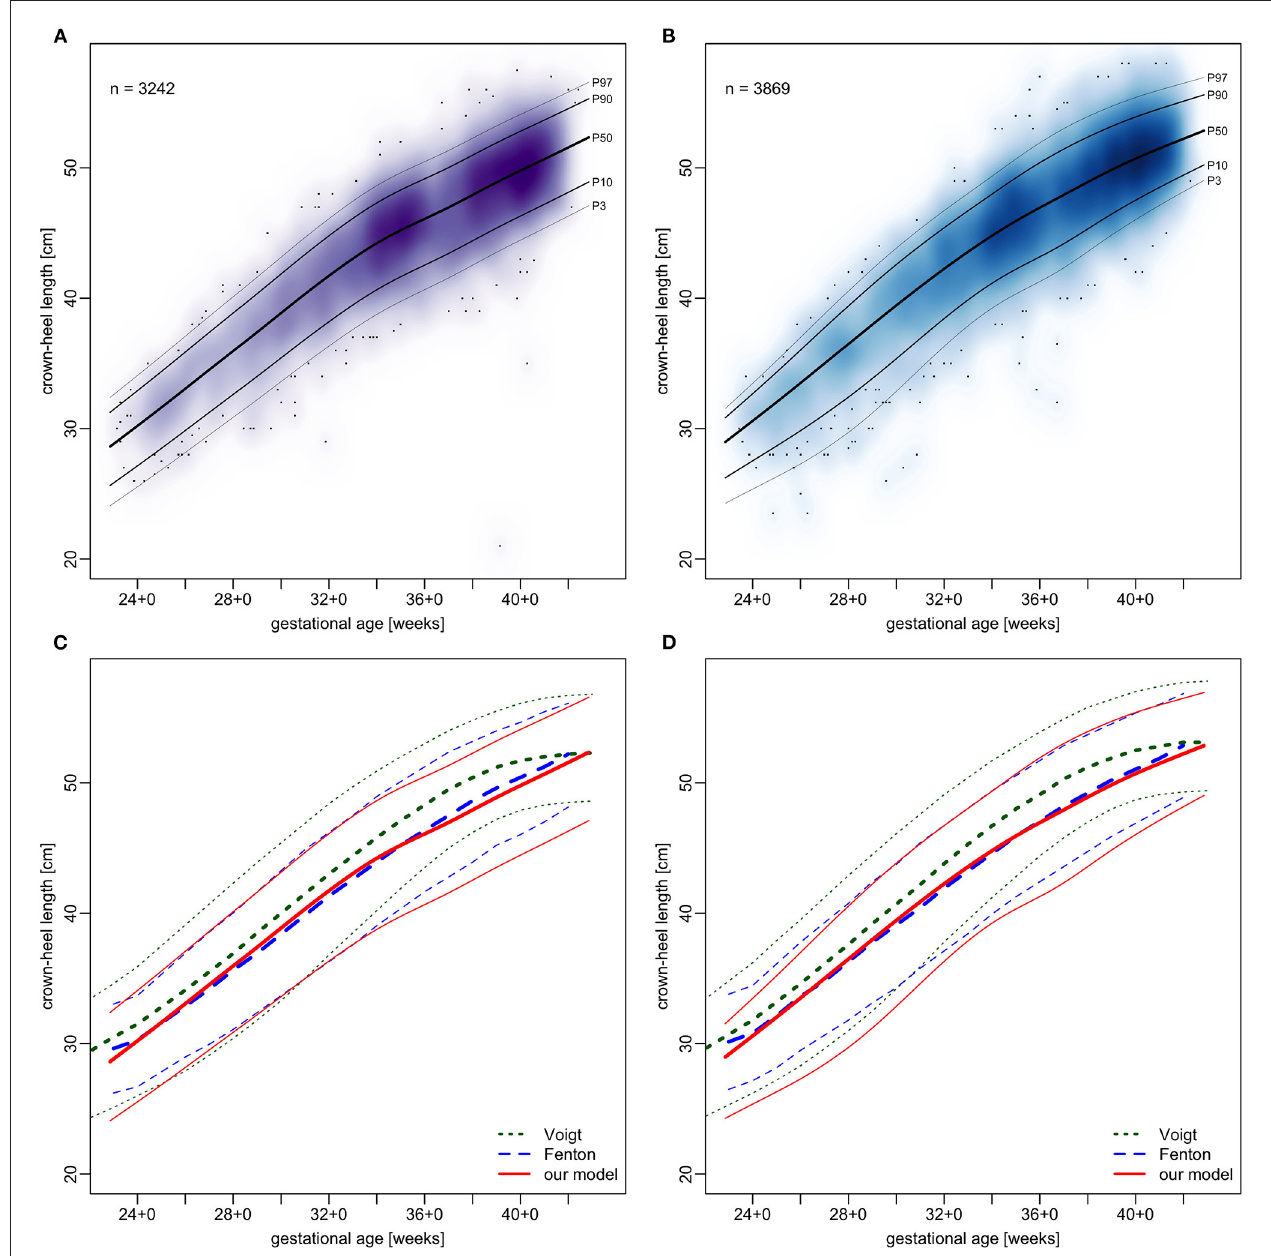
FIGURE 6 | Charts of crown-heel length in relation to gestational age. (A,B) our sample with fitted models. (C,D) comparison of our models (red) with Voigt et al. (17) (green) and Fenton and Kim (13) (blue), shown are 3rd, 50th, and 97th percentiles. (A,C) girls and (B,D)